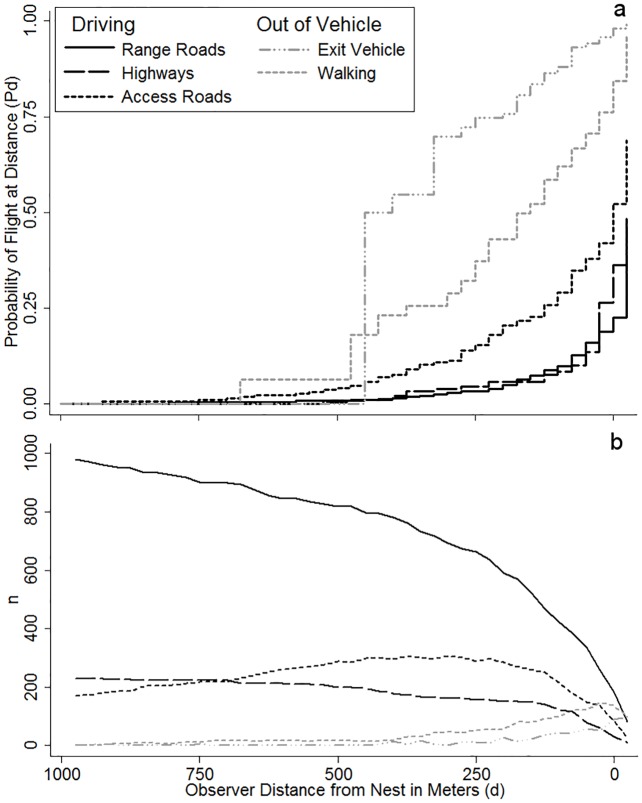
Kaplan-Meier (KM) failure estimator (Kaplan and Meier 1958) used to plot the probability of flight by adult Ferruginous Hawks from the nest at a given distance (a), specifying that they were exposed to investigators at those distances and had not previously initiated flight during the approach, and the sample size (number of instances) for which Ferruginous Hawks were exposed to an approach (b).Separate probability and sample size plots are shown for investigator approaches along highways, range roads and access roads. Additionally, separate plots are shown for walking (approaches on foot) and exiting the vehicle (the act of investigators parking and exiting their vehicle).